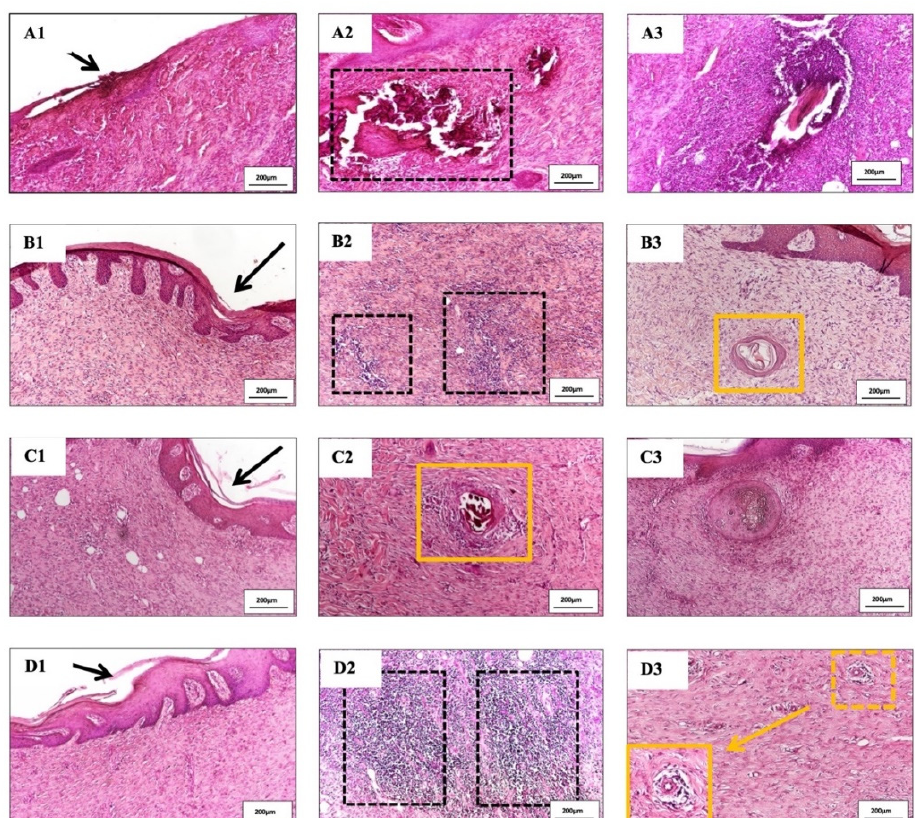
Figure 9. Magnified images of tissue sections of wounds treated with ( A1 – A3 ) normal gauze, ( B1 – B3 ) Aquacel, ( C1 – C3 ) UrgoTul, and ( D1 – D3 ) PCLGelAg membranes as mentioned above. The black arrows in figures ( A1 – D1 ) show new formed epidermis. The black dot border squares indicate the inflammatory areas ( B2 , D2 ) and necrosis area ( A2 ) of the wounds. Other images show new regenerated under skin structures including hair follicles, new blood vessels (yellow square boxes).